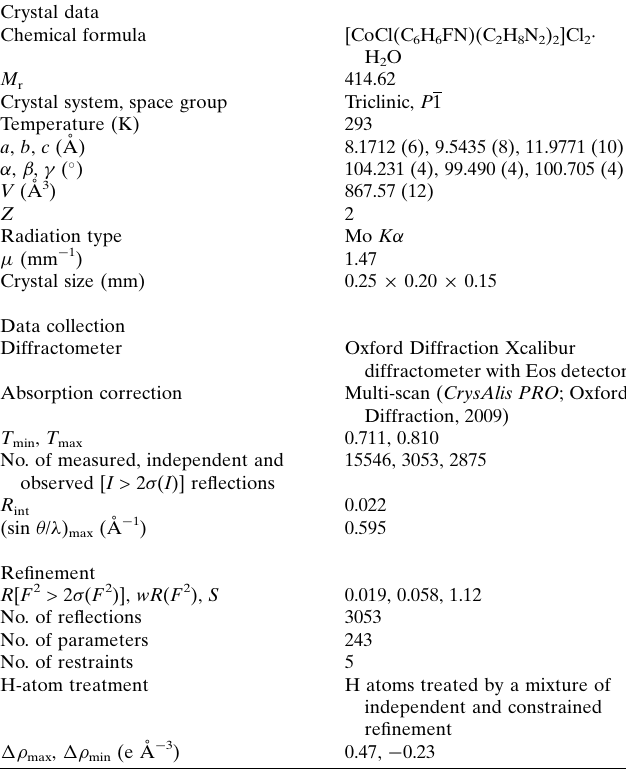
Crystal data Chemical